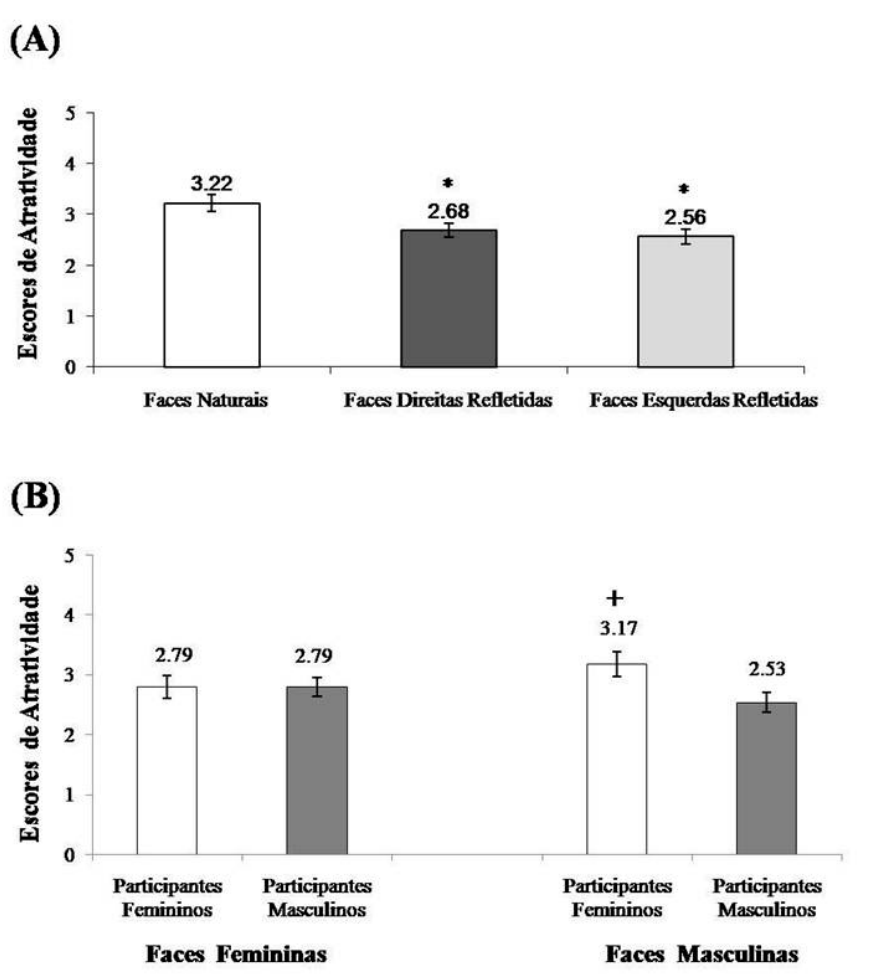
Figura 1 . Experimento I - Faces Com Componentes Internos e Externos Nota . Experimento I – Atratividades das faces com componentes internos e externos. (A) Efeito das condições de manipulação de simetria das faces. (B) Interação entre o sexo dos participantes e o sexo das faces. Barras de erro representam ±1 erro padrão da média. (* p <0,01, comparadas à média dos escores às faces naturais; + p <0,05, comparada à média dos escores dos participantes masculinos às faces